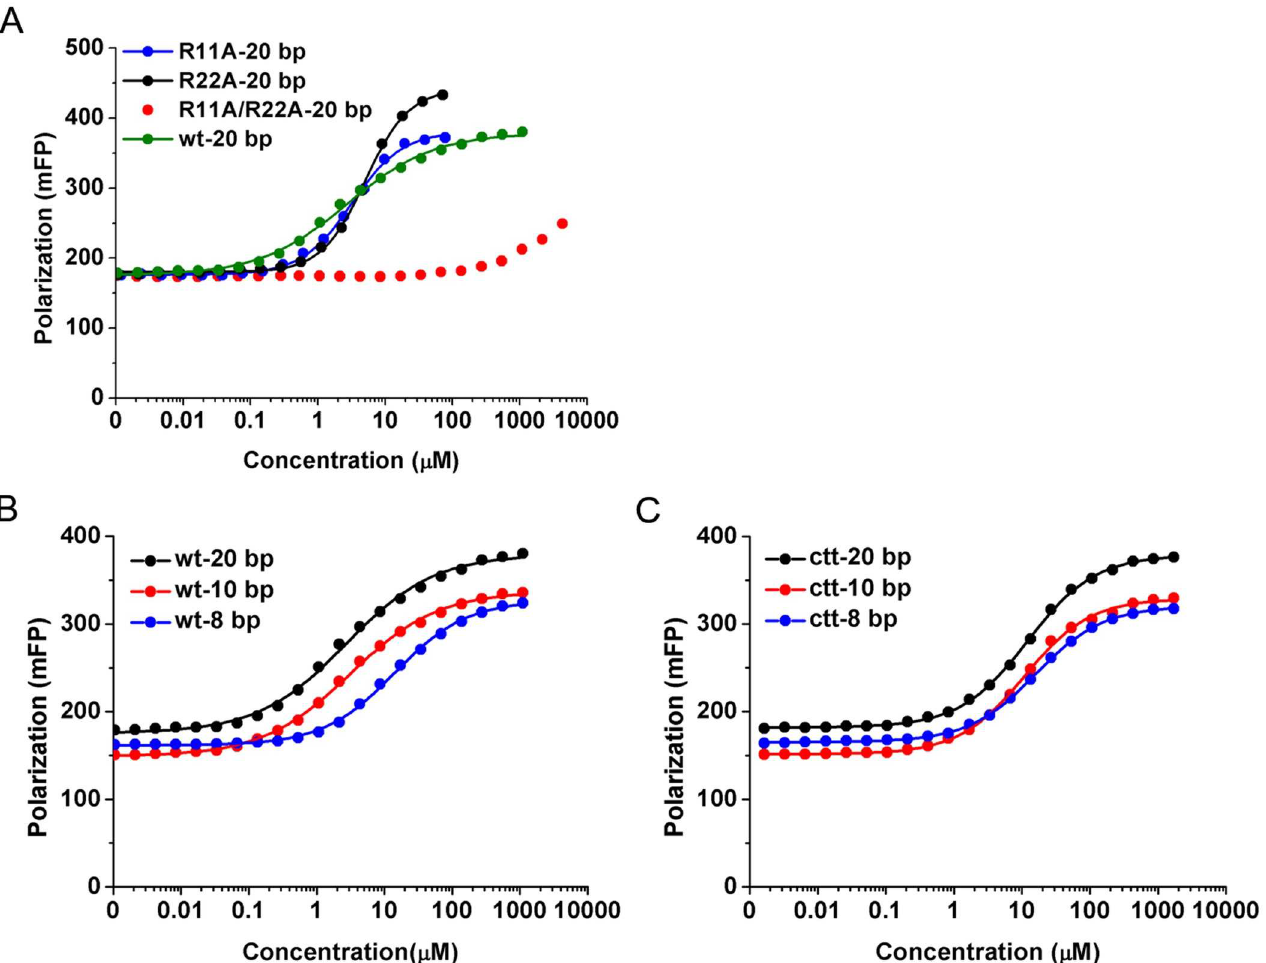
Fig 3. Sso7c4-DNAbinding assay using FP. (A) Argininemutant-DNA bindingcurves, (B) Wild-type Sso7c4-DNA bindingcurves, and (C) C- terminallytruncated Sso7c4-DNA bindingcurves. The wild-type(wt)/C-terminally truncated(ctt) proteins were bound to 8-, 10- and 20-bp DNAs, and the three argininemutants, Sso7c4-R11A, Sso7c4-R22A and Sso7c4-R11A/R22A, were bound to a 20-bp DNA in bindingbuffer. The graph depicts the averagetraces of three independent experiments for each sample, and the data points indicate the averagevalues of technical replicatesmeasured in triplicate.